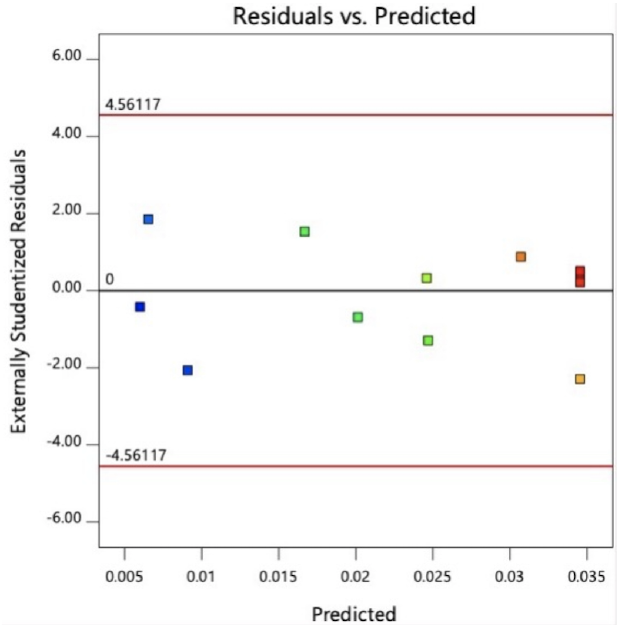
Molecules 2022 , 27 , x FOR PEER REVIEW 6 of 15 Figure 3. Residual analysis of ODU from 2-Level Factorial. Figure 3. Residual analysis of ODU from 2-Level Factorial.